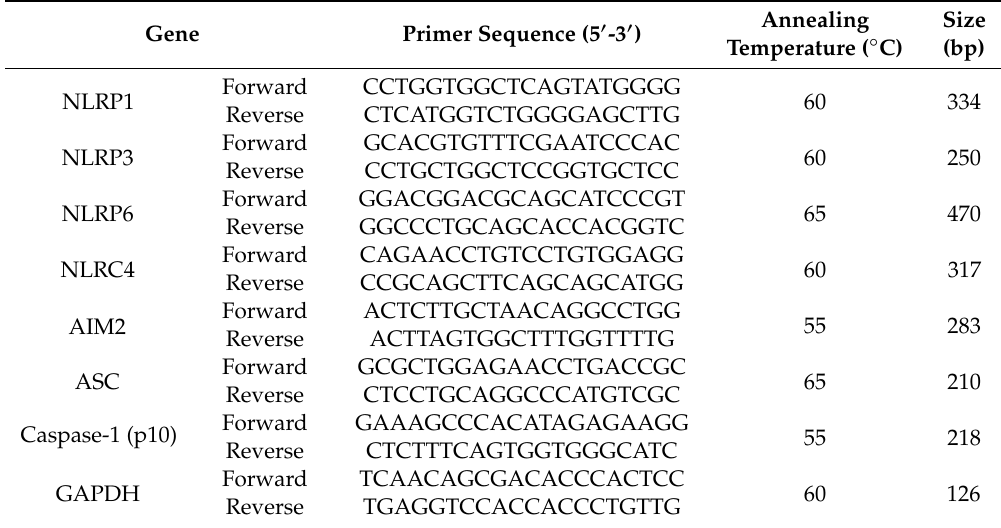
Table 1. RT-PCR primer sequences for inflammasome